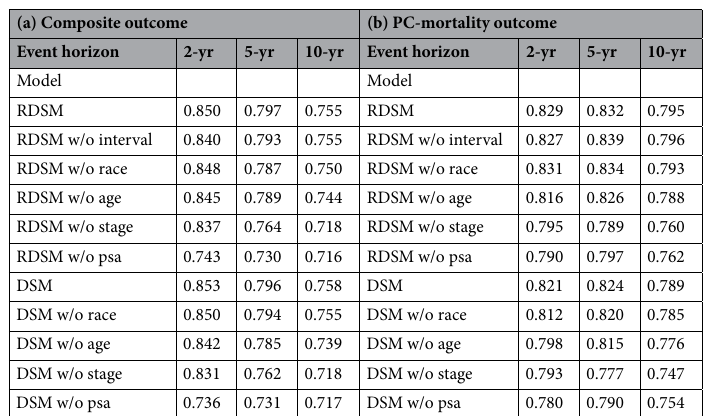
(a) Composite outcome (b) PC-mortality